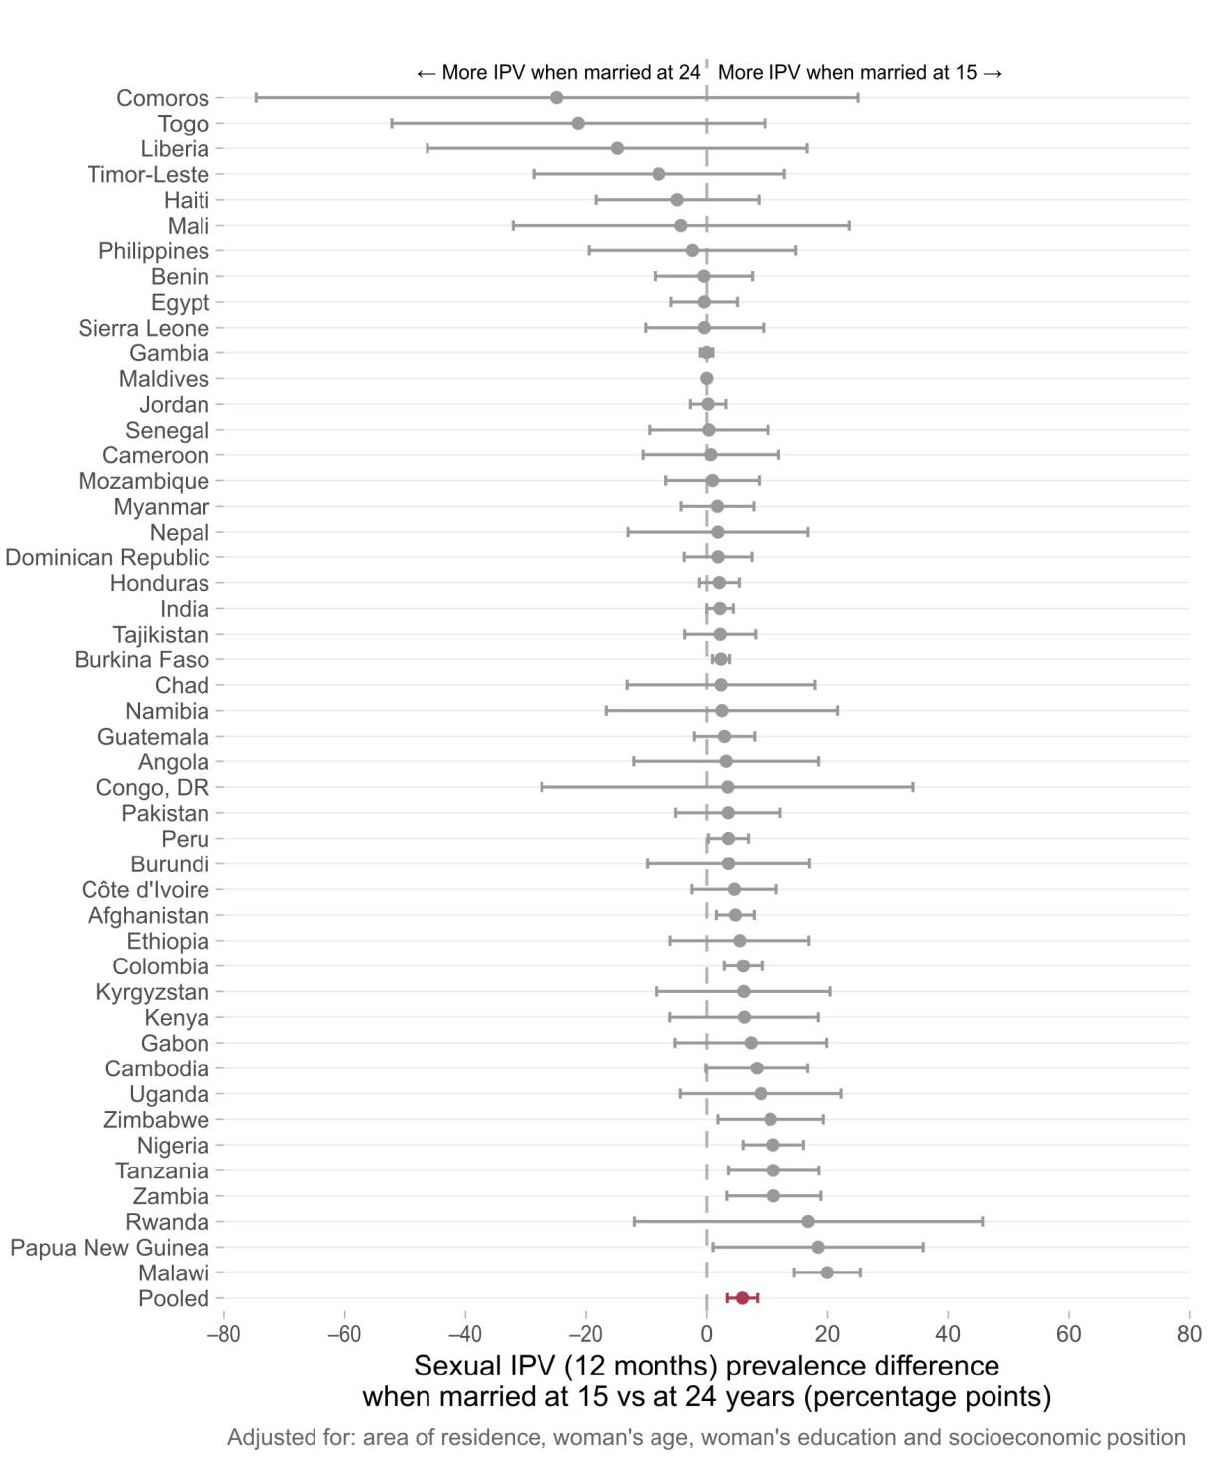
Figure 3. Difference between the average sexual IPV prevalence among women aged 20–24 years first married at 15 years and at 24 years of age. Individual results for 48 low- and middle-income countries obtained from logistic regression models. The pooled estimate of the prevalence difference in past year sexual IPV (in red) was 5.9 percentage points (95% CI 3.4 – 8.4).